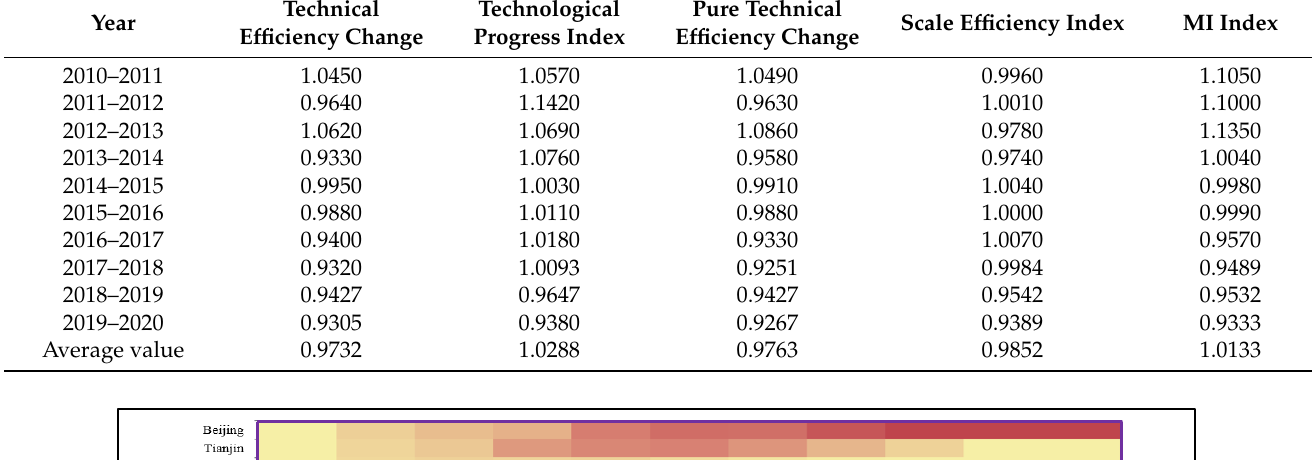
Table 5. The decomposition index of the DEA-Malmquist model in 2010–2020.